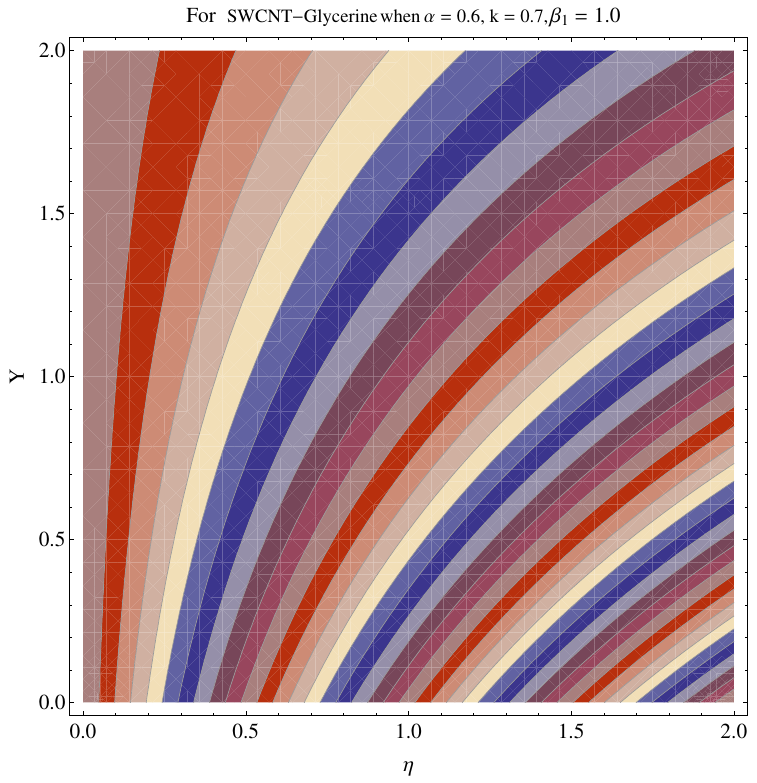
Figure 21. Contour graph at β 1 = 1.0 for SWCNT-Glycerine at larger k .